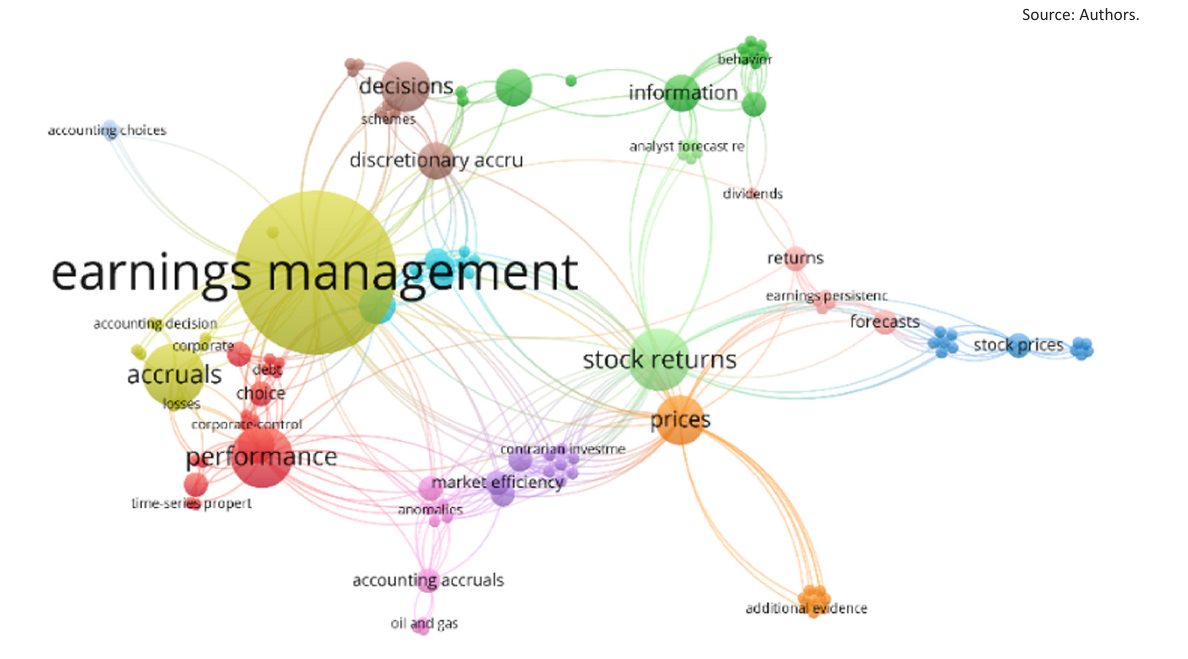
Figure 3. Keyword science maps for Earnings Management, 1900–2000